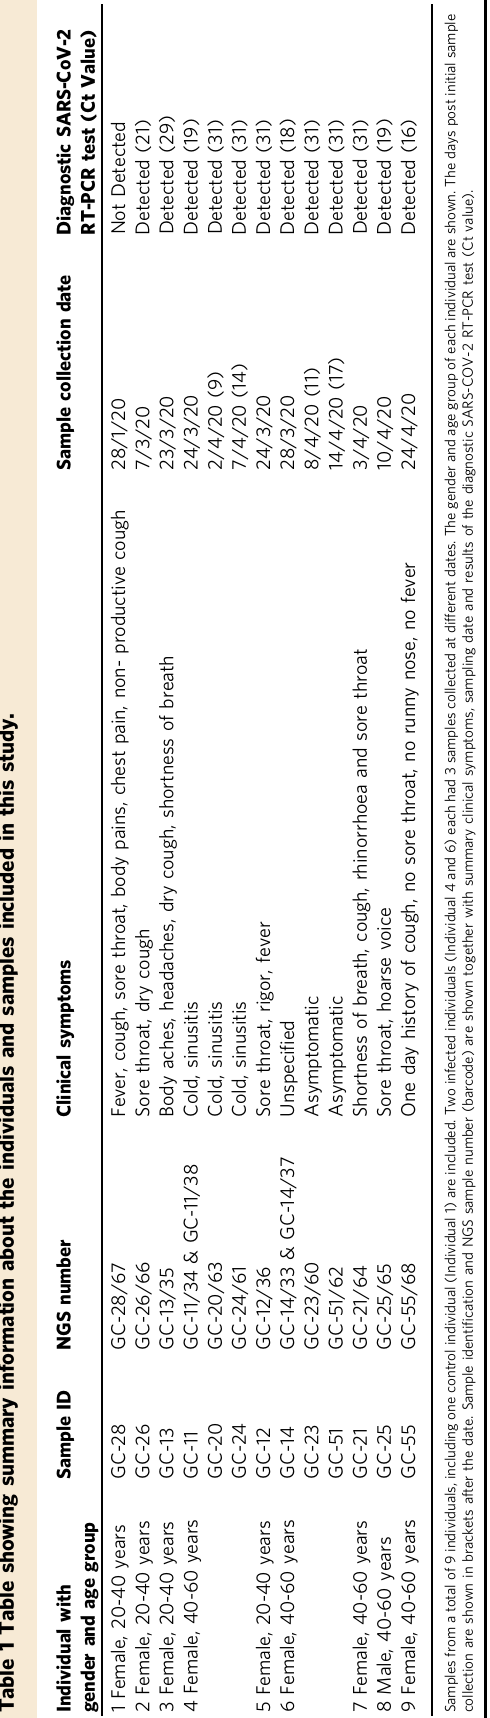
Comparing samples ampli fi ed with two different polymerases (Table 3; sample GC-11/34 compared with sample GC-11/38 and GC-14/33 compared with GC-14/37) and comparing samples with longer average read length and high virus coverage (Table 3; samples GC-26/66, GC-11/38, GC-24/61, GC-14/37, and GC-23/60) did also, although with some variability from sample to sample, generate a somewhat comparable